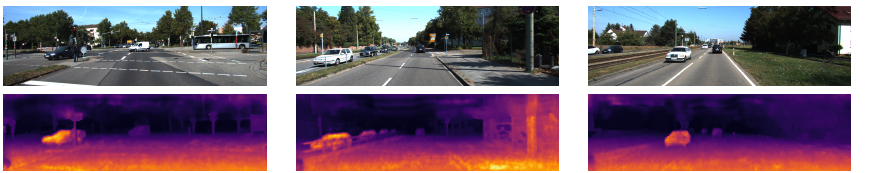
Figure 7. The qualitative results from [29] show the left RGB images from 3 scenes in the KITTI-2015 stereo dataset in the top row and the corresponding disparity map predictions in the bottom row are shown using colour to represent the disparity values. The raw dataset was used for the LiDAR data mapped onto the scenes in the stereo dataset and then the results were converted from depth values to disparity using the calibration